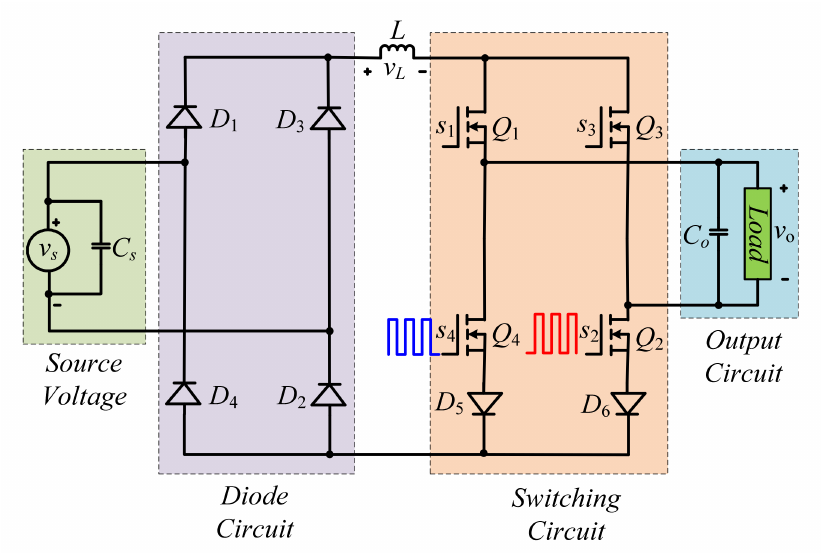
Figure 6. Proposed circuit